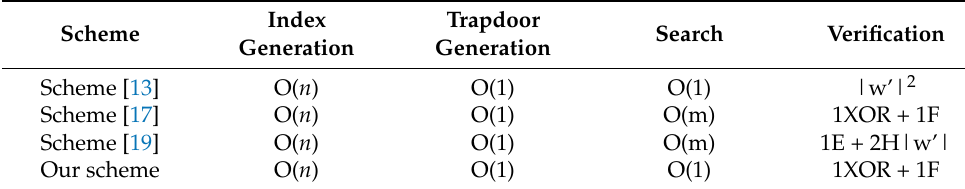
Table 3. Performance